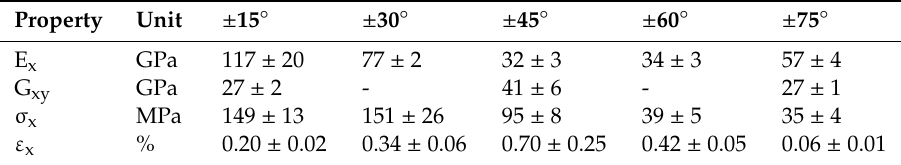
Table 1. Mechanical properties of C / C–SiC obtained from tensile and shear tests for di ff erent fiber orientations.